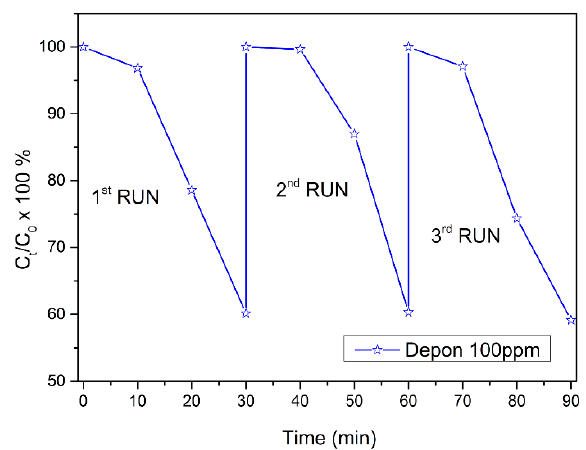
Figure 6. % APAP (100 ppm) degradation using a 40% w/w TiO 2 /PS 3D-printed nanocomposite sample under UV-A irradiation, for 3 runs of 30 min irradiation each.